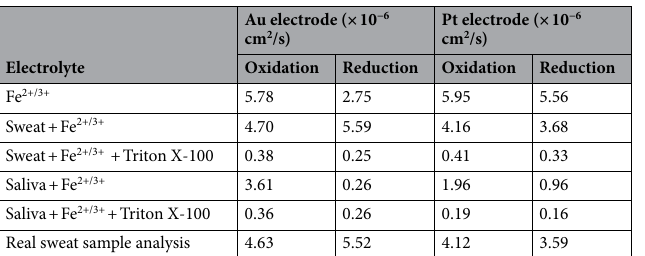
Pt electrode (× 10 −6 cm 2 /s)